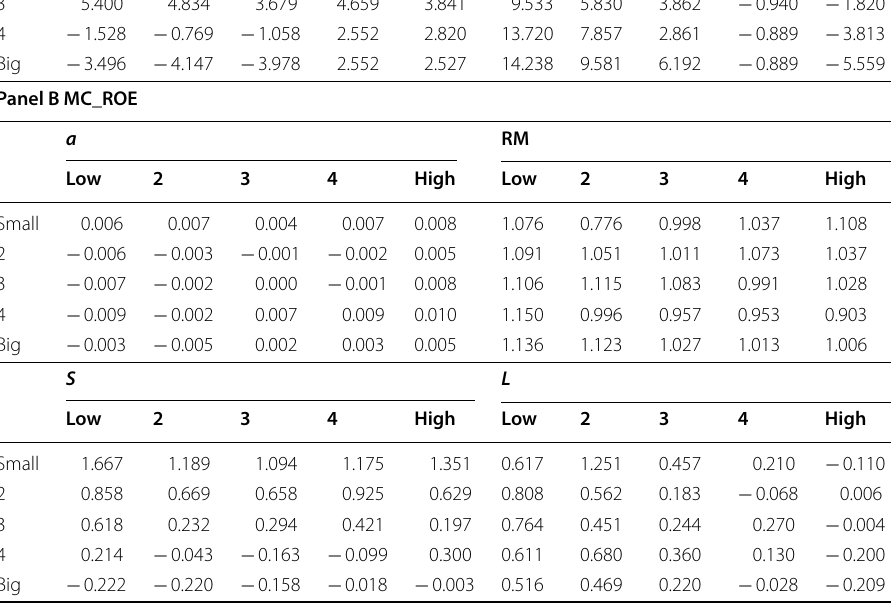
R a b ( R R ) s SMB Pt − Ft = Mt − Ft + +